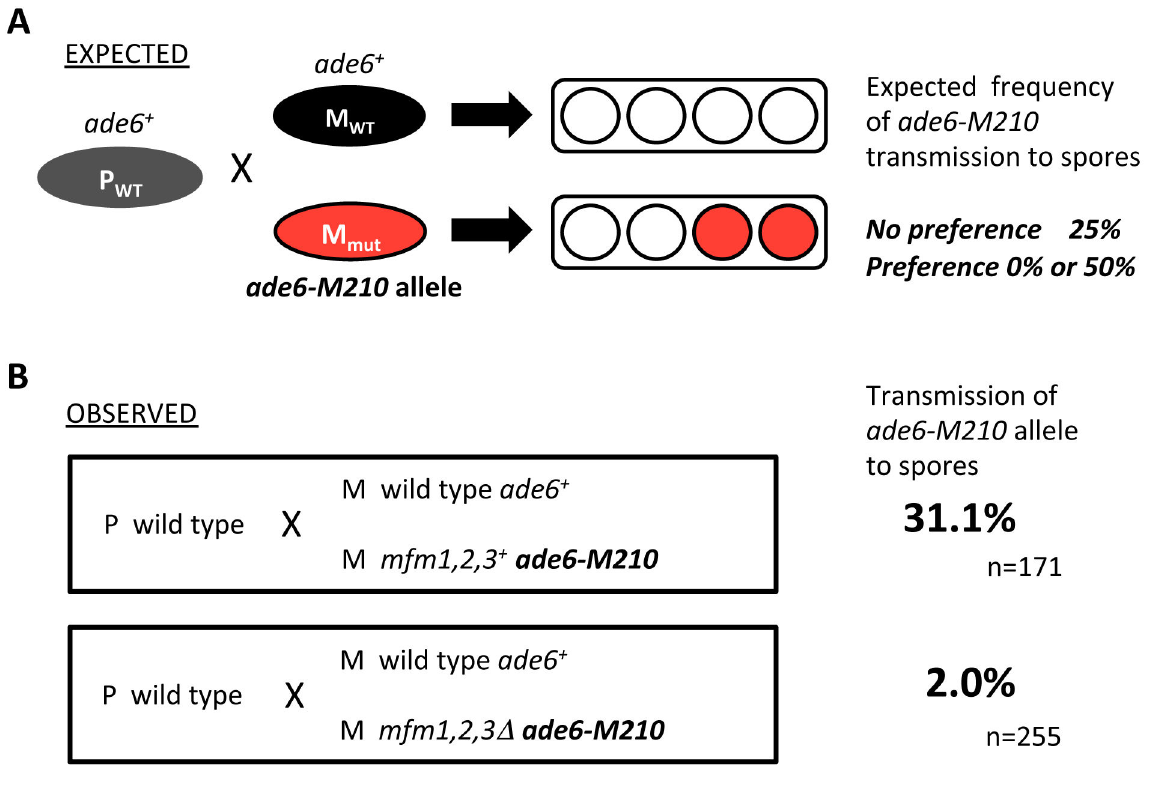
Figure 6. P-cells preferentially mate with wild-type M-cells. (A) Experimental design. Wild-type P-cells (P ) were mixed with WT an equal number of wild-type M-cells (M ) and M-factor-less M-cells (M ), marked by the ade6-M210 auxotrophic marker, in WT mut nitrogen-free medium. If the P-cell chose an ade6 + M-cell, the descendant spore clones would have no ade6-M210 allele. If the P- cell chose an ade6-M210 M-cell, the allele would be transmitted to half of the descendant spore clones. Thus, the preference of P- cells for type of mating partner could be determined by the frequency of ade6-M210 segregants. (B) Experimental results. The following strains were used: L972 ( h – prototrophic), L975 ( h + prototrophic), FS120 ( h – mfm1,2,3Δ ade6-M210 ), and FS121 ( h – mfm1,2,3 + ade6-M210 ). The mixed cells were allowed to mate, and resulting hybrid diploids were sporulated. Spores were isolated by micromanipulation and grown on nutrient medium with adenine sulfate limitation. doi: